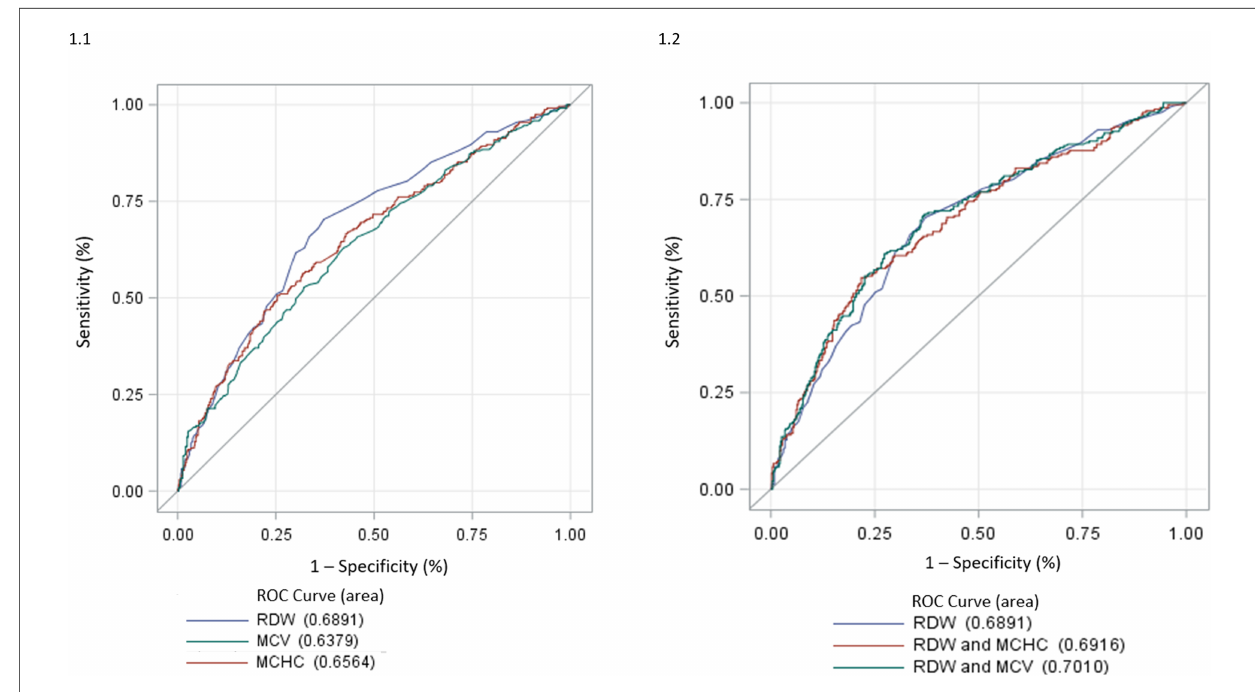
FIGURE 3 Percentage of patients with RDW </ ≥ 14.2% divided by eGFR values, with IIT prevalence in each group. An RDW cut-off of 14.2% performs best in excluding IIT in patients with eGFR ≥ 60 ml/min. eGFR, estimated glomerular fi ltration rate; IIT, impaired iron transport; RDW, red distribution